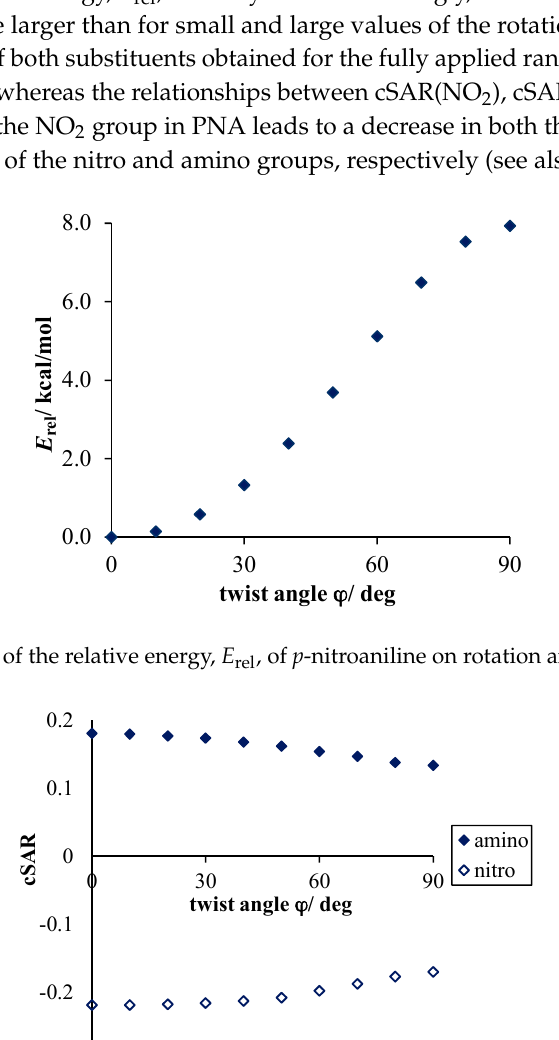
Figure 10. Dependence of cSAR(NO 2 ) and cSAR(NH 2 ) on rotation angle of NO 2 group, φ , for PNA.